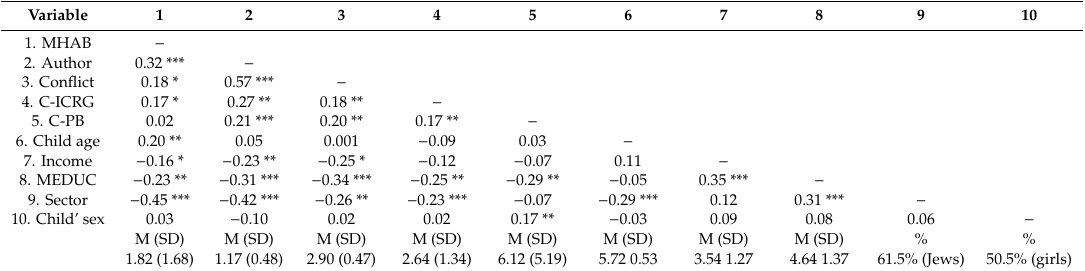
Table 1. Descriptive statistics and correlations for person-level averages of all study variables and